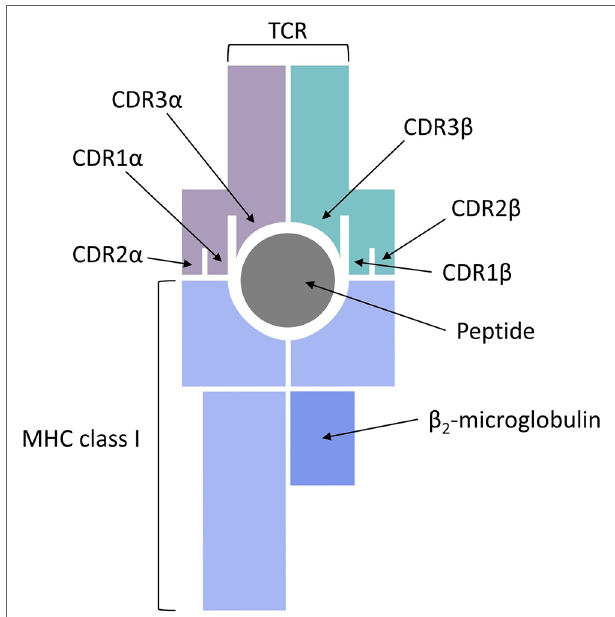
FIGURE 5 | IEDB and VDJdb contents of CDR3α and CDR3β sequences of human origin. IEDB contains 386 unique epitopes linked to CDR3α sequences and 426 unique epitopes linked to CDR3β sequences. For VDJdb there are 93 and 177 unique epitopes, respectively. IEDB data was downloaded from https://www. iedb.org on September 30th, 2019 with the following query parameters: Current Filters: No B cell assays, No major histocompatibility complex (MHC) ligand assays, Restriction Type: Class I, Host: Homo sapiens (human). VDJdb data was taken from https://vdjdb.cdr3.net/overview (last updated on August 7th, 2019).